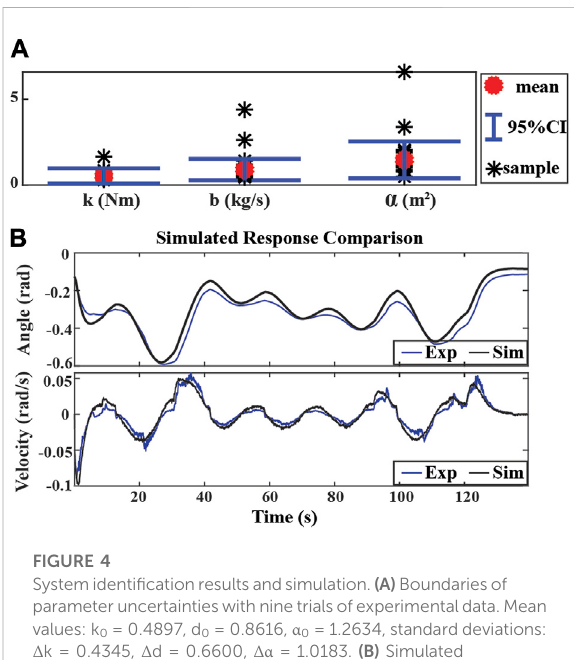
FIGURE 4 Systemidenti fi cationresultsandsimulation. (A) Boundariesof parameteruncertaintieswithninetrialsofexperimentaldata.Mean values: k 0 = 0.4897, d 0 = 0.8616, α 0 = 1.2634, standard deviations: Δ k = 0.4345, Δ d = 0.6600, Δα = 1.0183. (B) Simulated response comparison of experimental result (solid blue) and simulation result (solid black).